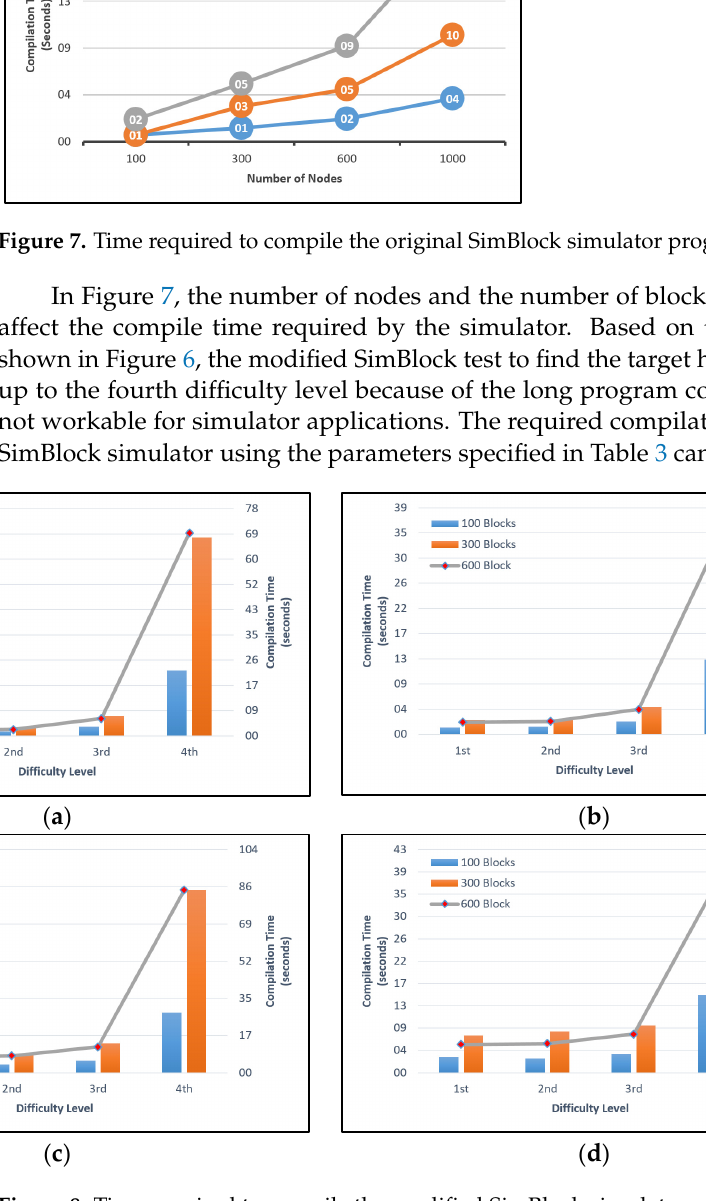
Figure 8. Time required to compile the modified SimBlock simulator program with ( a ) 100 Nodes; ( b ) 300 Nodes; ( c ) 600 Nodes; ( d ) 1000 Nodes.